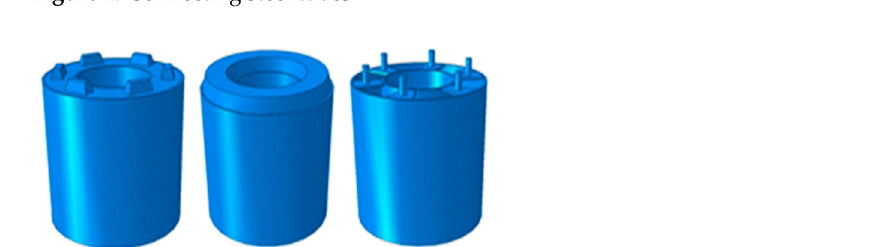
Figure 2. Connecting steel tubes.